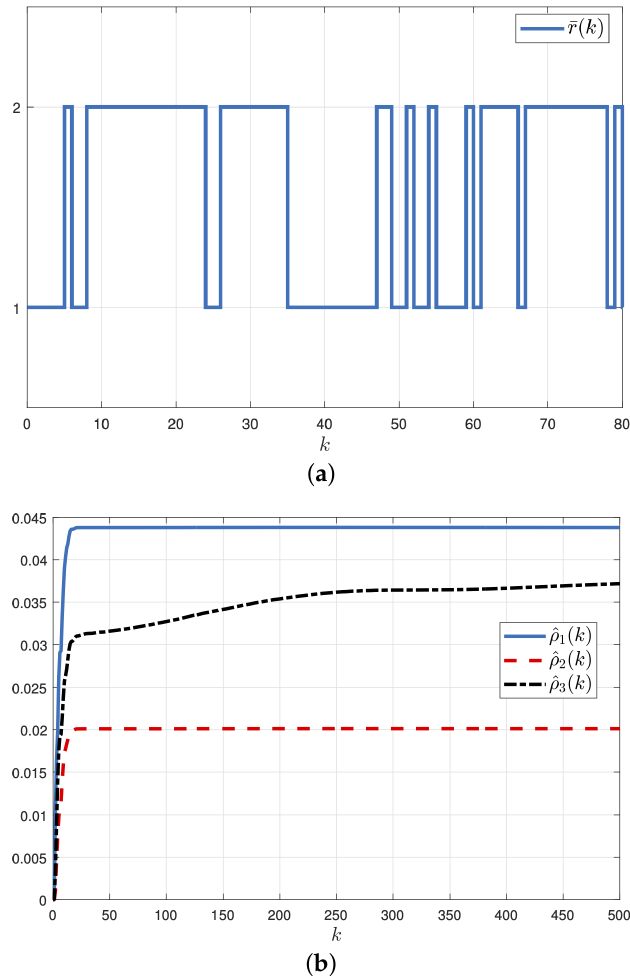
Figure 8. A possible sequence of system mode ( a ) and trajectory of the adaptive variables ( b